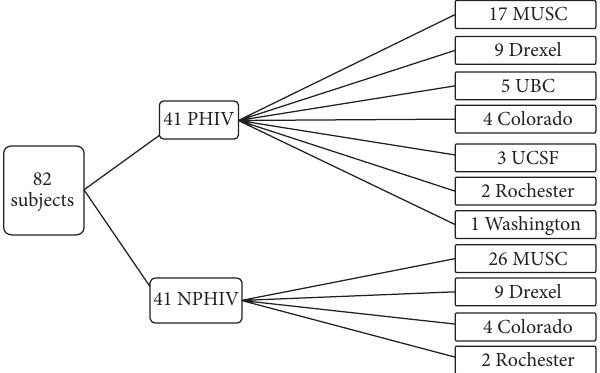
Figure 1: Site recruitment of pregnant women with perinatal and nonperinatal HIV infection. Site key: MUSC, Medical University